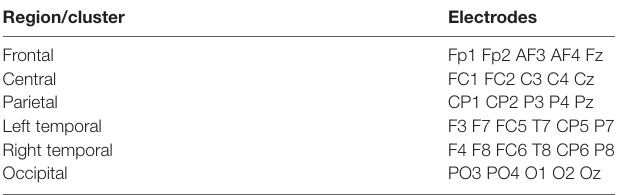
TABLE 1 | Electrodes in each region.